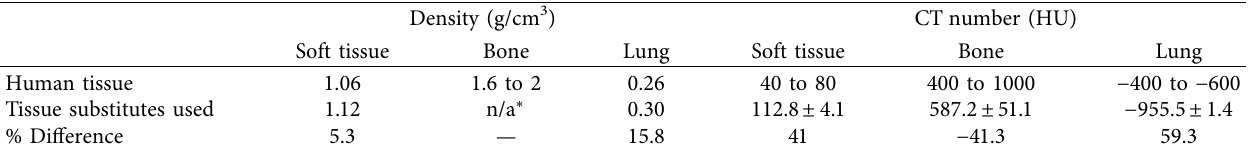
Table 1: The comparison of density and CTnumbers of human tissue and tissue substitute materials. Polyester resin, polyester resin with 40% CaCO 3 , and polyurethane foam were used as soft tissue, bone, and lung, tissue-equivalent materials,